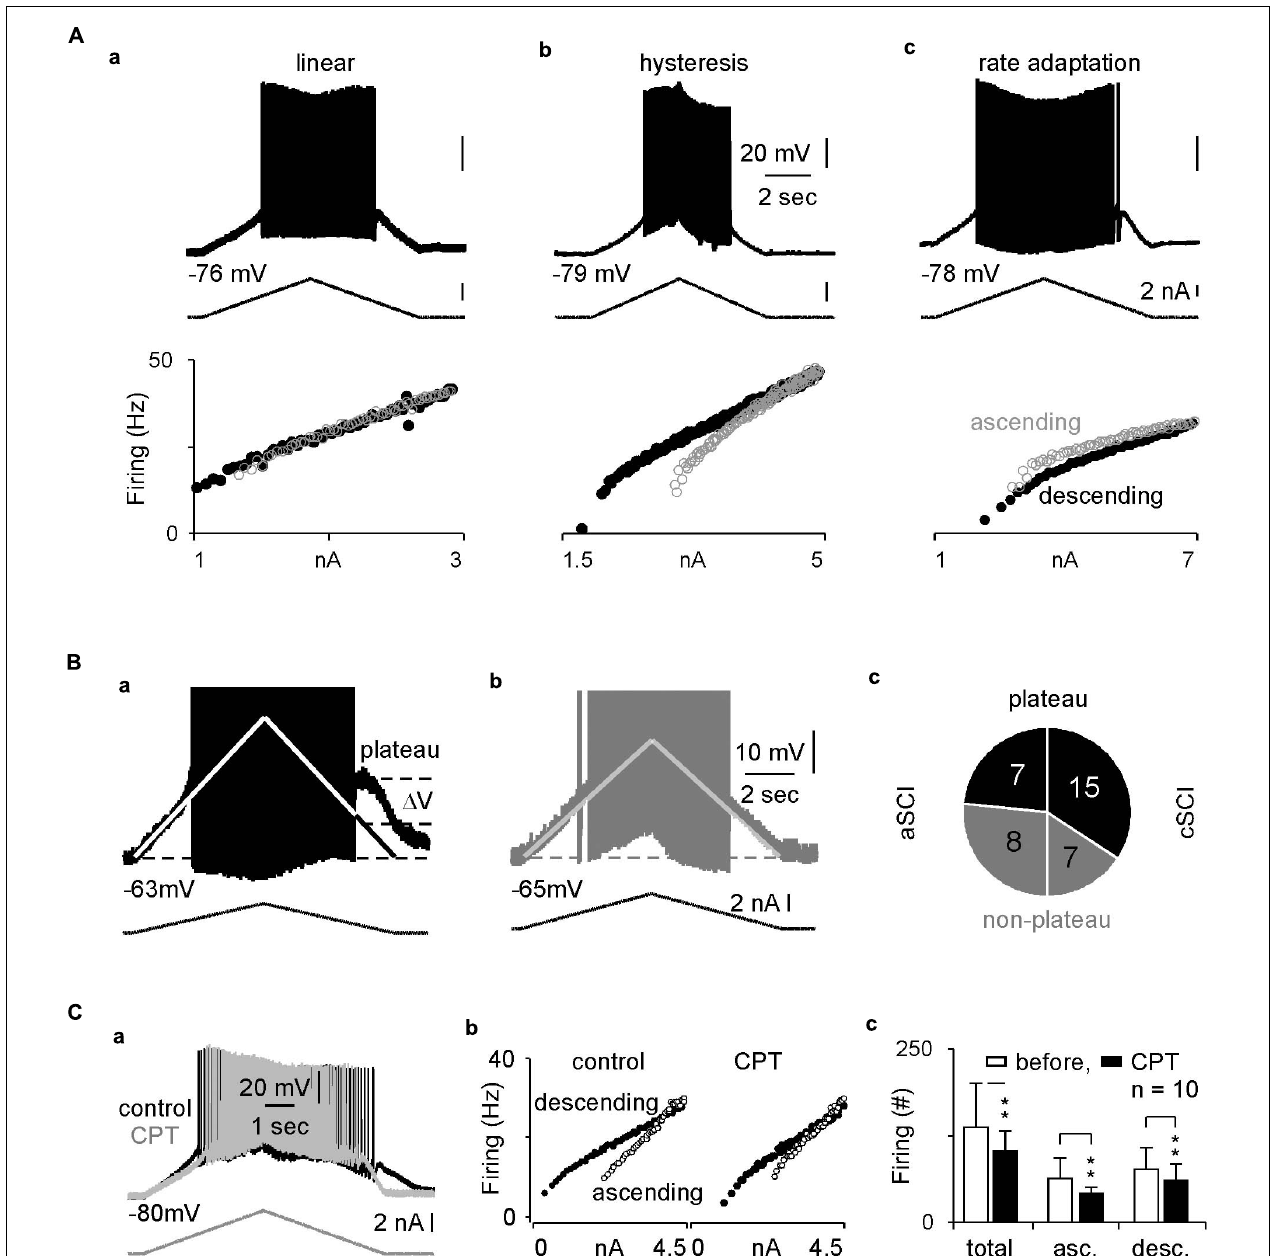
FIGURE 5 | Intracellular recordings and inhibitory effects of CPT on MNs. (A) Sample recordings show three types of intrinsic firings in (a–c). The top, middle and bottom rows display membrane potentials, ramp current and scattered frequency-current relations. (B) Plateau potentials. The sample recordings show plateau potential as indicated in a MN from a cSCI mouse in (a), but not a MN from an aSCI mouse in (b). The pi plot in c indicates distribution of plateau potentials in MNs between aSCI and cSCI mice. (1) the white lines represent linear relation between membrane potential and current injection due to passive membrane resistance, upon which the amplitude of plateau potential is estimated; (2) APs are truncated to have better resolution to display plateau potential. (C) The effect of CPT on intrinsic firing. Two overlapped sample recordings show intrinsic firings before and after CPT application in a MN from a cSCI mouse in (a), which is converted to scattered frequency-current plots in (b). Histograms in c illustrate the inhibitory effect of CPT on intrinsic firings during wholecurrent injection and different phases of current injection. The asterisks represent the result of t -tests (** p < 0.01).